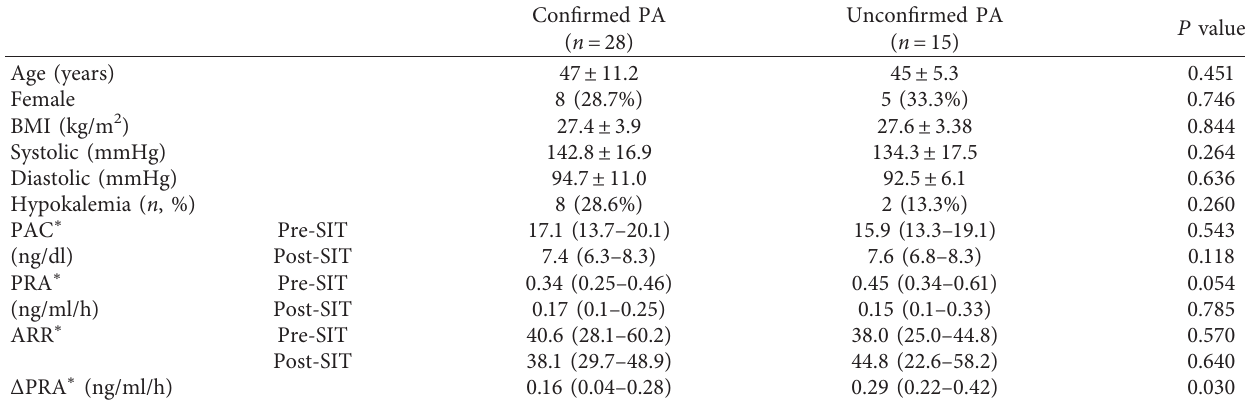
Table 3: Characteristics of 43 patients with inconclusive SIT results and completed